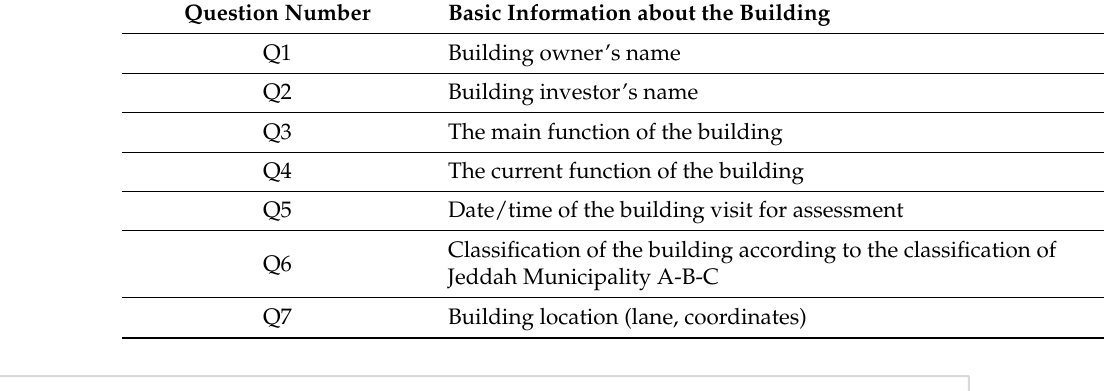
Table 2. Building basic information questions.